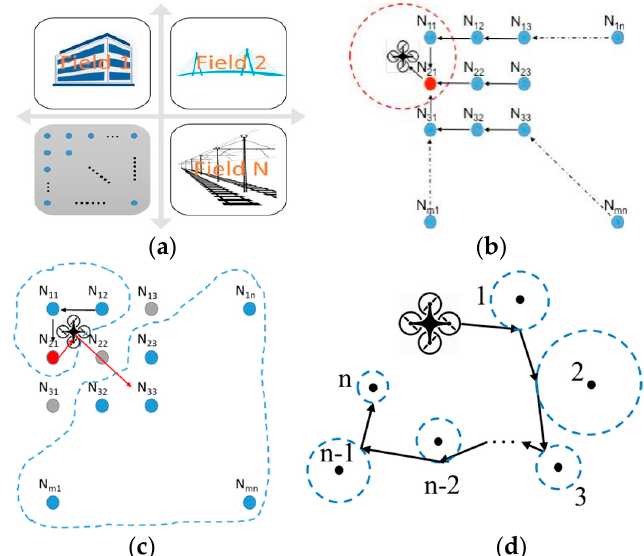
Figure 2. Conceptual field development of an AG-WSN and opportunistic networking: ( a ) sample field sub-networks; ( b ) a sub-network case wherein all sensors work normally and the UAV receives data directly or via relay without flying to individual sensors; ( c ) a sub-network case wherein some sensor failure is allowed and the UAV needs to be mobile to collect data; and ( d ) a sub-network case wherein the sensors are far with each not allowing relay, and the UAV needs to be fully mobile to fly to individual sensors for data collection.